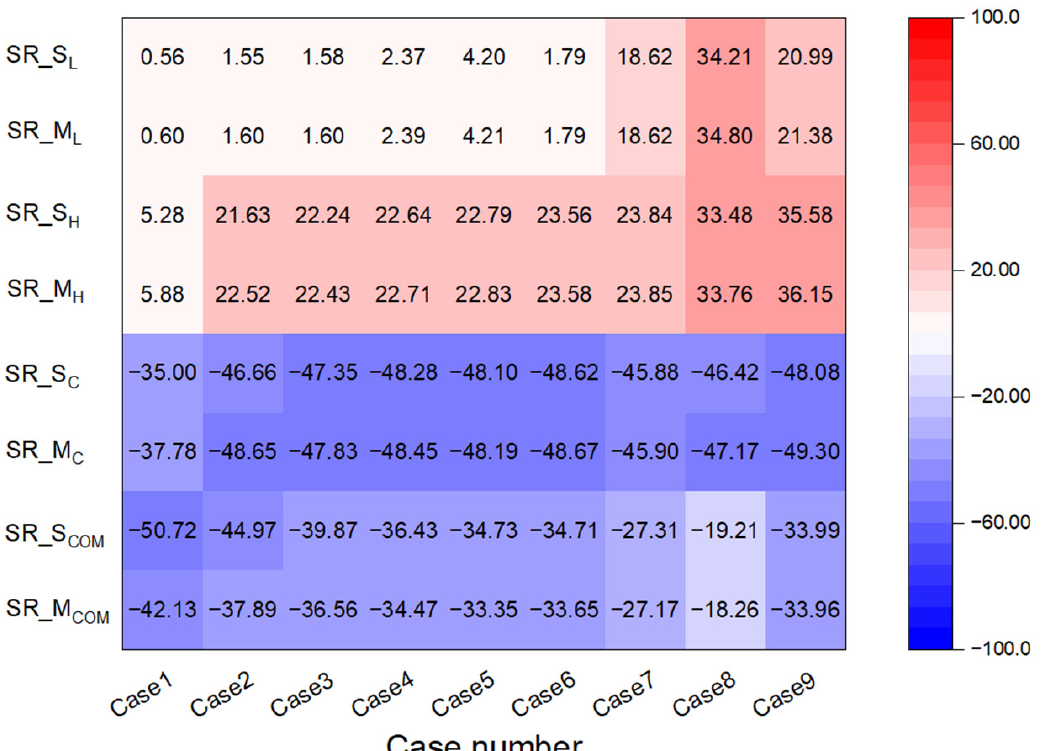
Figure 14. Energy saving analysis of building with different PVSDs in Beijing.